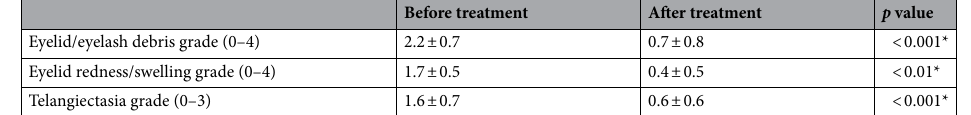
Table 1. Comparison of anterior blepharitis and clinical manifestations between before and after topical azithromycin treatment (mean ± standard deviation). Asterisks indicates statistically significant p -values.